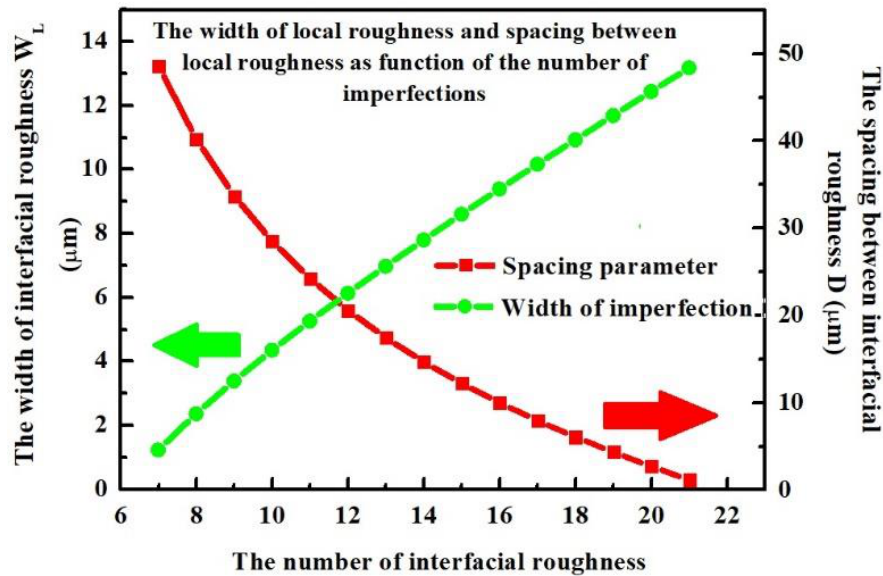
W as a function of the L